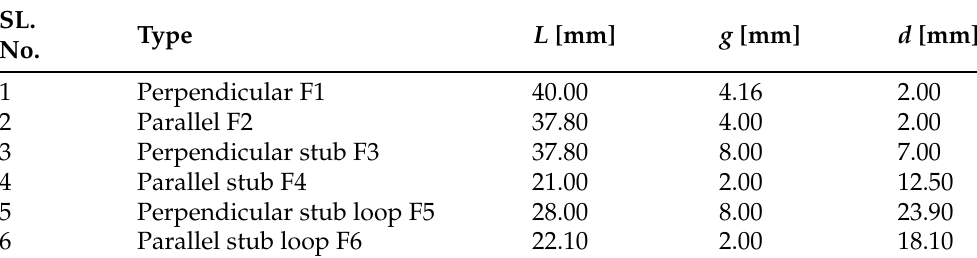
Figure 9. Validation of the empirical relations (2)–(4). Main resonance peak vs. substrate di- electric permittivity ε r comparisons between semi-analytical formulas and numerical simulations, ( a ) configuration in Figure 3, ( b ) configuration in Figure 5 and ( c ) configuration in Figure 7. Table 1. Prototypes dimensions comparisons; ε r = 4.0, h = 1.6